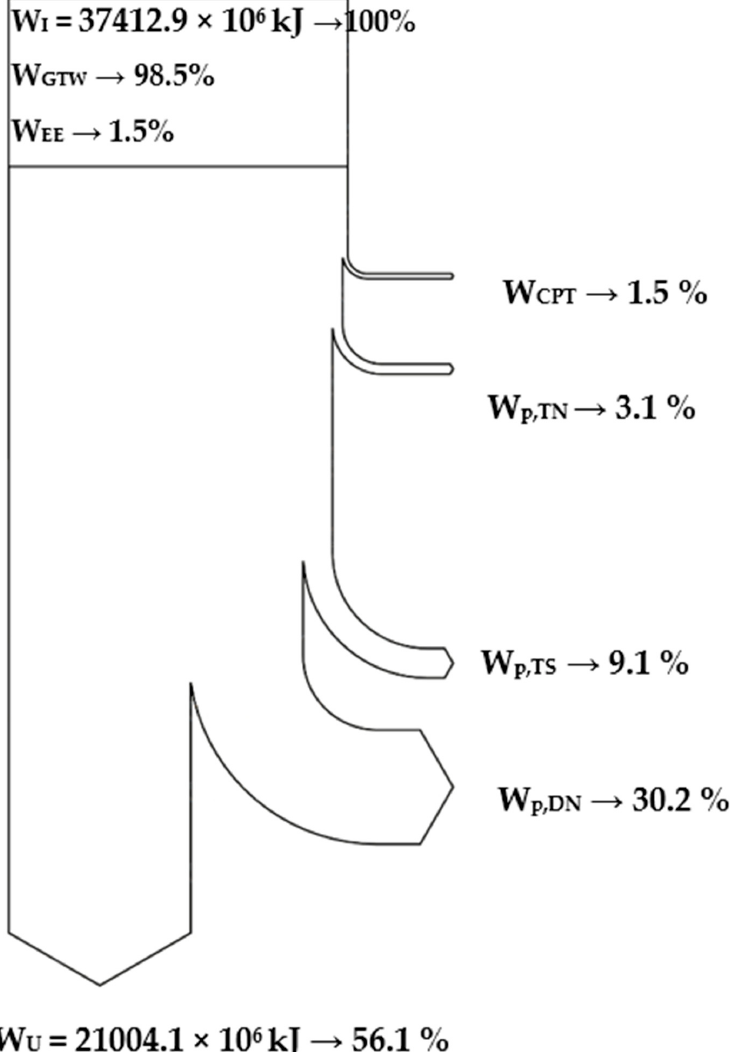
Figure 12. Energy flow diagram of the real CEB for HSGWPE [overall year 2019]. Figure 11. Energy flow diagram of the real hourly CEB, 20–22 January 2020.